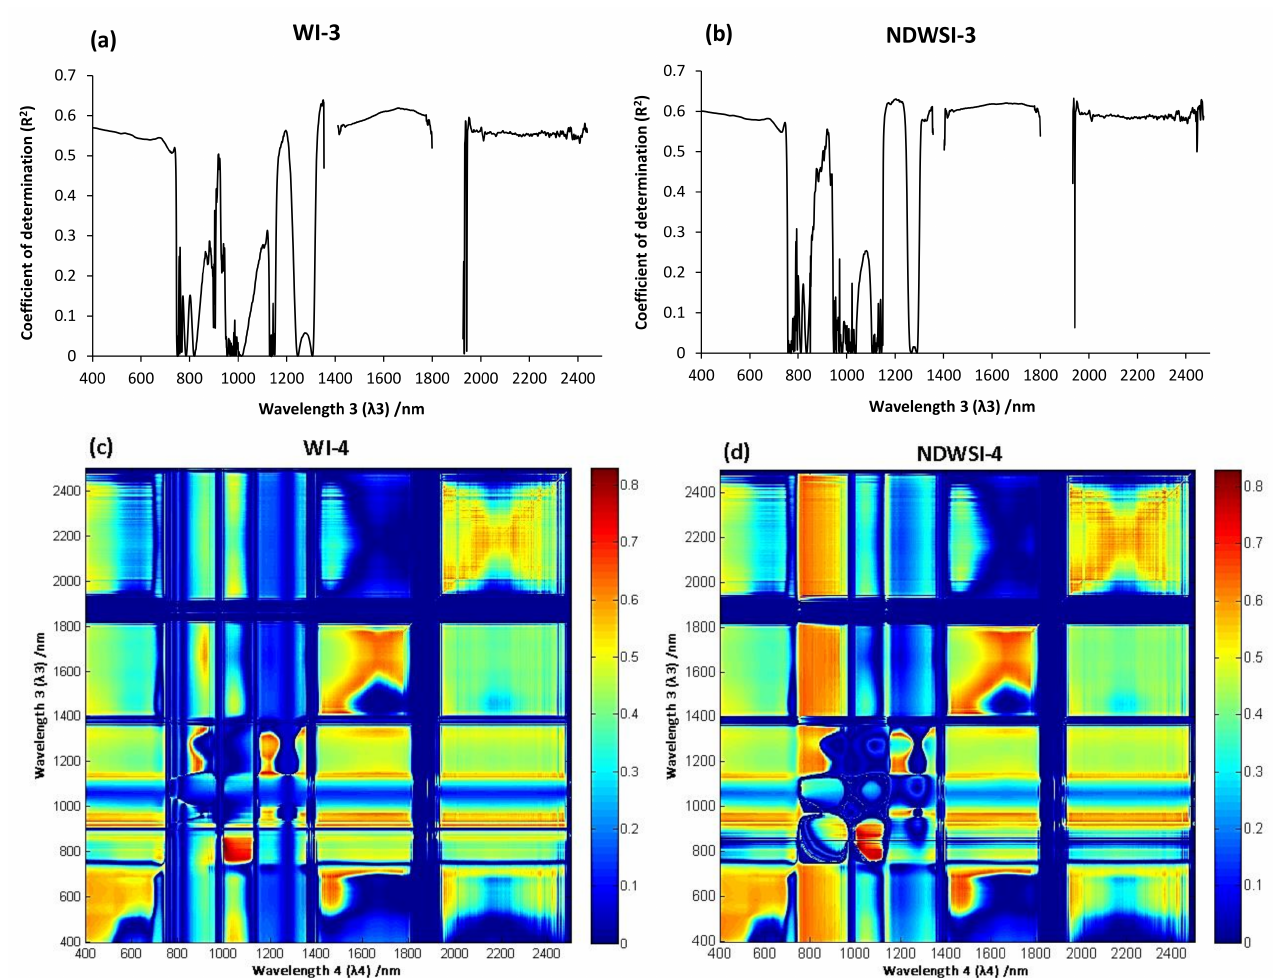
Figure 6. The R 2 curves between middle-LWC vs. ( a ) the WI-3 and ( b ) NDWSI-3 indices when using each waveband over 400–2500 nm as the third band ( λ 3); R 2 contour maps between middle-LWC vs. ( c ) the WI-4 and ( d ) NDWSI-4 indices when using all possible combinations over 400–2500 nm as the third ( λ 3) and forth bands ( λ